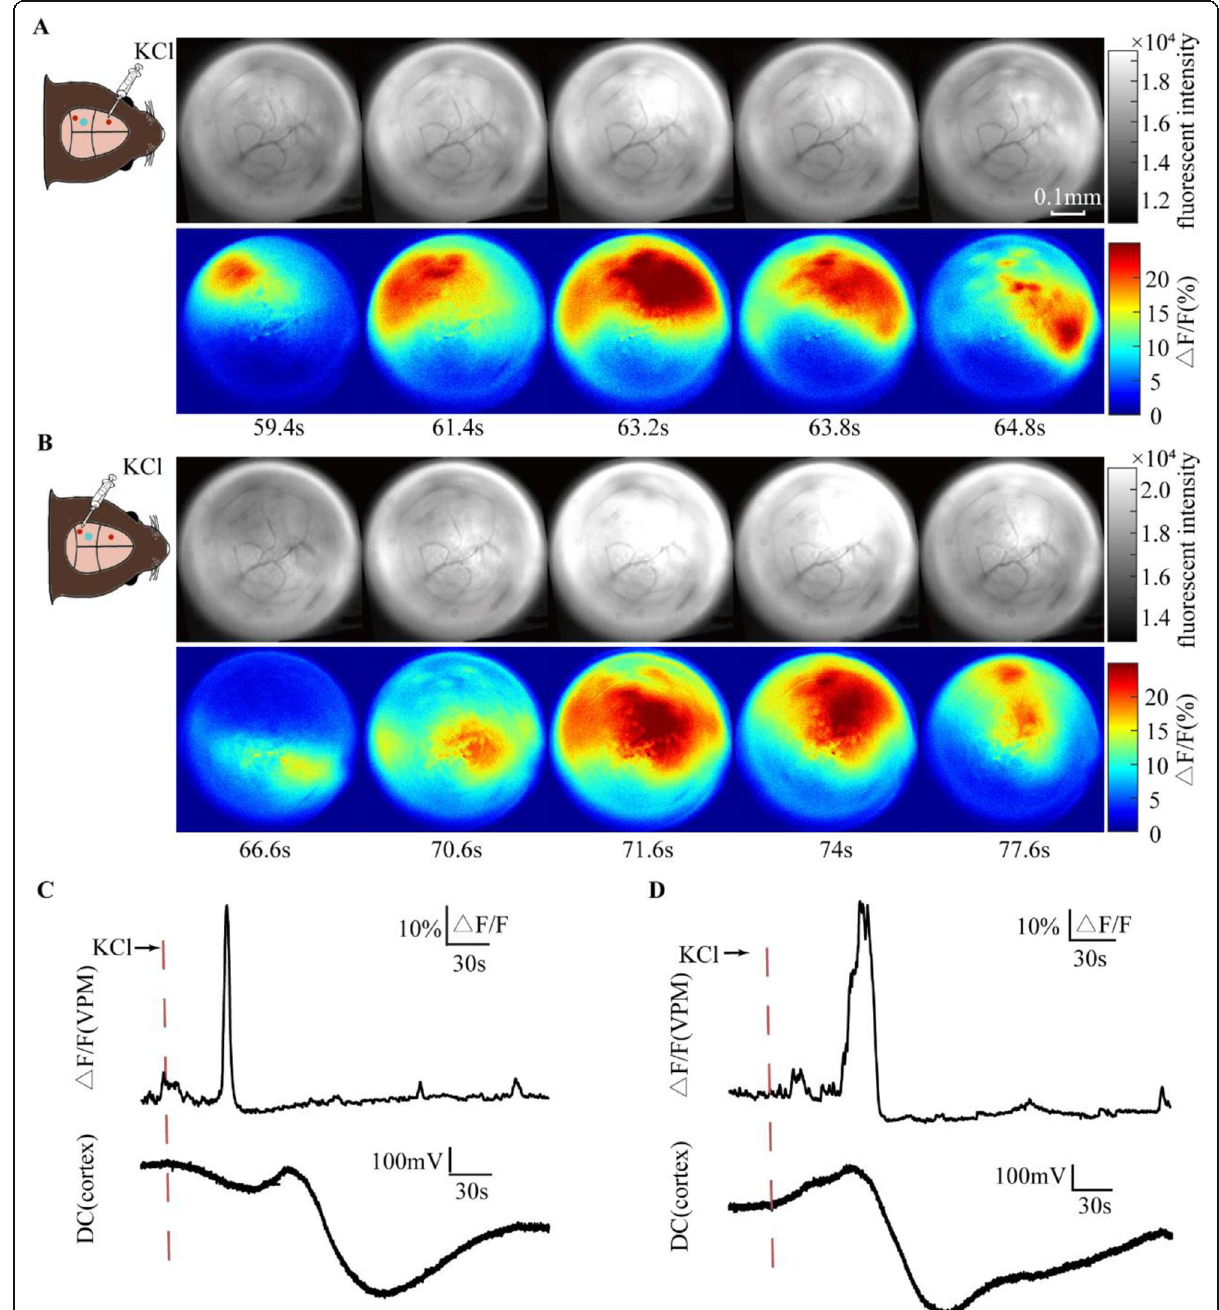
Fig. 5 Different propagating directions of VPM responses when CSD was induced in motor cortex and visual cortex respectively. A When CSD was induced in motor cortex, the response propagated from the posterior-lateral to the anterior-medial side of the VPM. B In the same mouse, when CSD was induced in visual cortex, the response propagated in opposite direction, from the anterior-medial to the posterior- lateral side of the VPM. C The fluorescence intensity changes of the VPM and the simultaneous DC shift in the cortex when CSD was induced in motor cortex. D The fluorescence intensity changes of the VPM and the simultaneous DC shift in the cortex when CSD was induced in visual